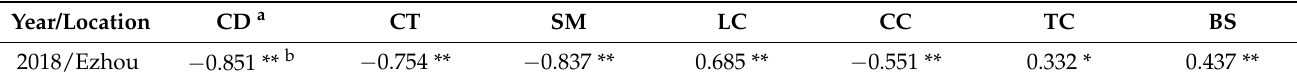
Table 6. Analysis of the correlations between the relative value of lodging-related traits of twelve indica rice cultivars and the T mean during the determined growth durations on the three sowing dates in 2018 at